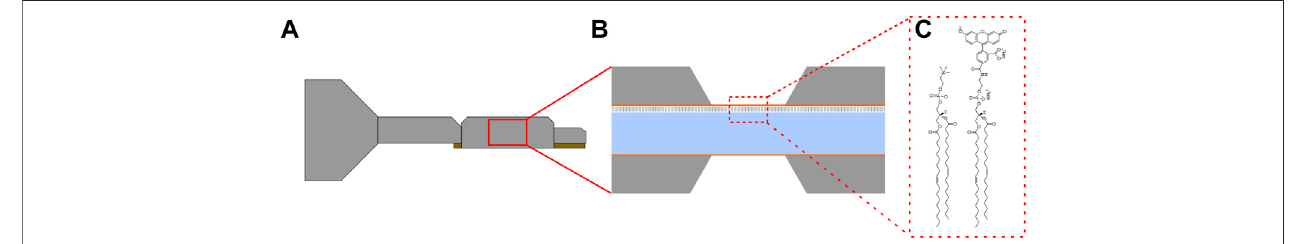
FIGURE 1 | (A) Illustration of a liquid cell transmission electron microscope holder which contains an assembled set of silicon device fi lled with the sample. (B) Cross section illustration of a liquid cell, with a lipid bilayer on the upper silicon nitride membrane. (C) The lipids used for monolayer formation,